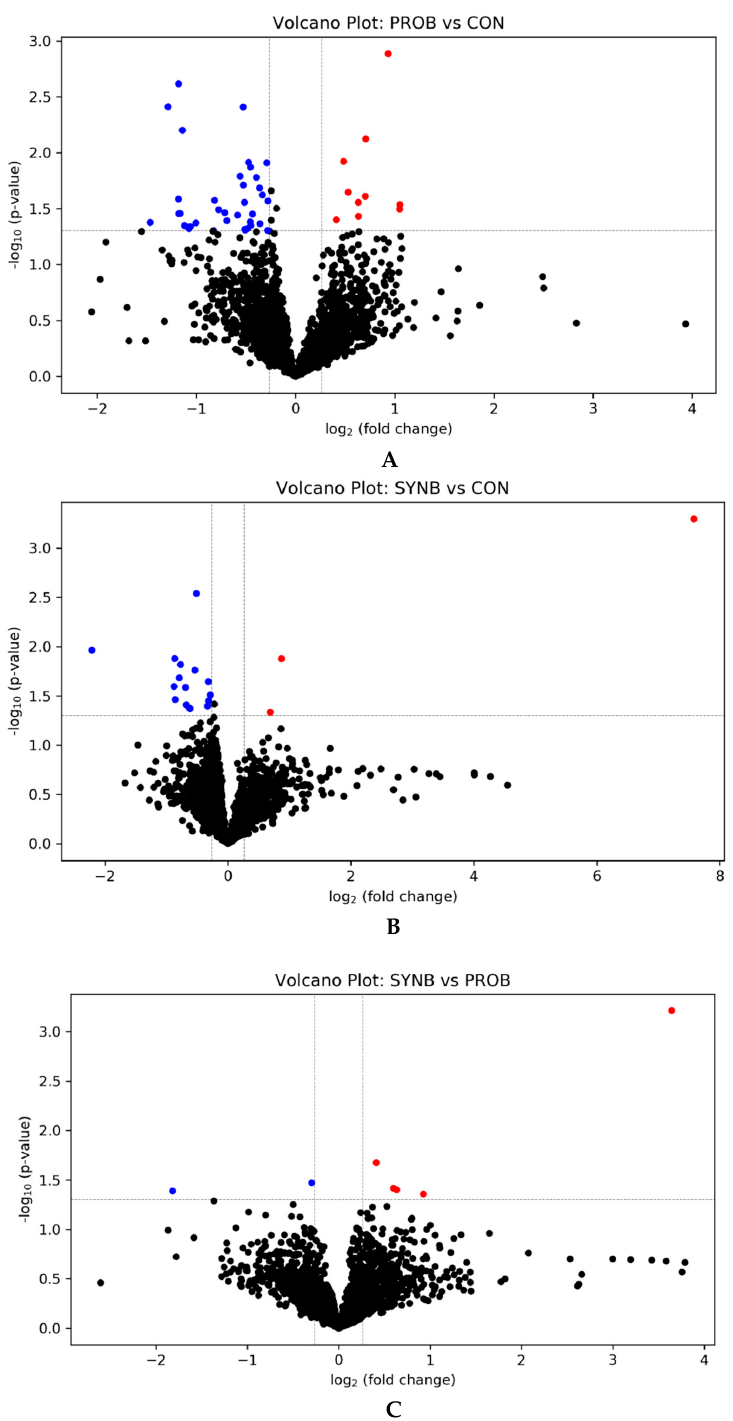
Figure 5. Volcano plots ( A ) CON vs. PROB, ( B ) CON vs. SYNB, and ( C ) PROB vs. SYNB, showing the differential ruminal metabolites in beef steers fed diets supplemented with S. cerevisiae -based direct-fed microbial products. FC ≥ 1.2, p-value ≤ 0.05 (in red)—significantly increased; FC ≤ 0.83, p-value ≤ 0.05 (in blue)—significantly reduced relative to CON. CON = control; PROB = a blend of S. cerevisiae , Enterococcus lactis, Bacillus subtilis, Enterococcus faecium, and L. case i, and their fermentation products fed at 19 g/steer/day (PMI, Arden Hills, MN); SYNB = a blend of live S. cerevisiae and the fermentation products of S. cerevisiae, Enterococcus lactis , Bacillus licheniformis , and Bacillus subtilis fed at 28 g/steer/day (PMI, Arden Hills, MN) . Table 2. Identified ruminal metabolites that were altered in beef steers fed diets supplemented with direct-fed microbials containing multiple microbial species and their fermentation products.